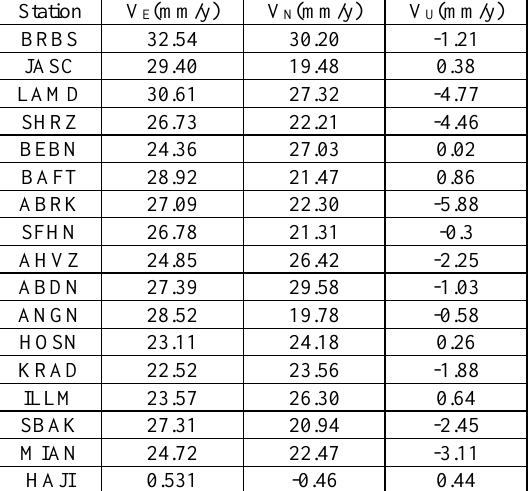
Table 2. The velocity vectors of the permanent stations Station